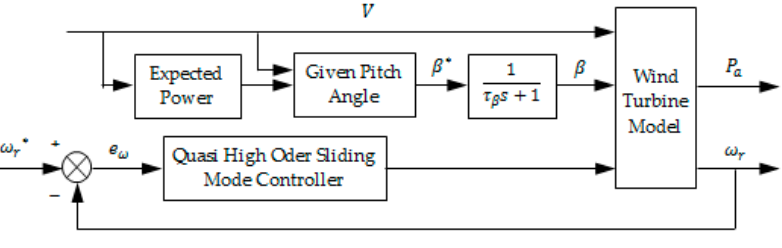
Figure 2. Variable speed control scheme for wind turbine.